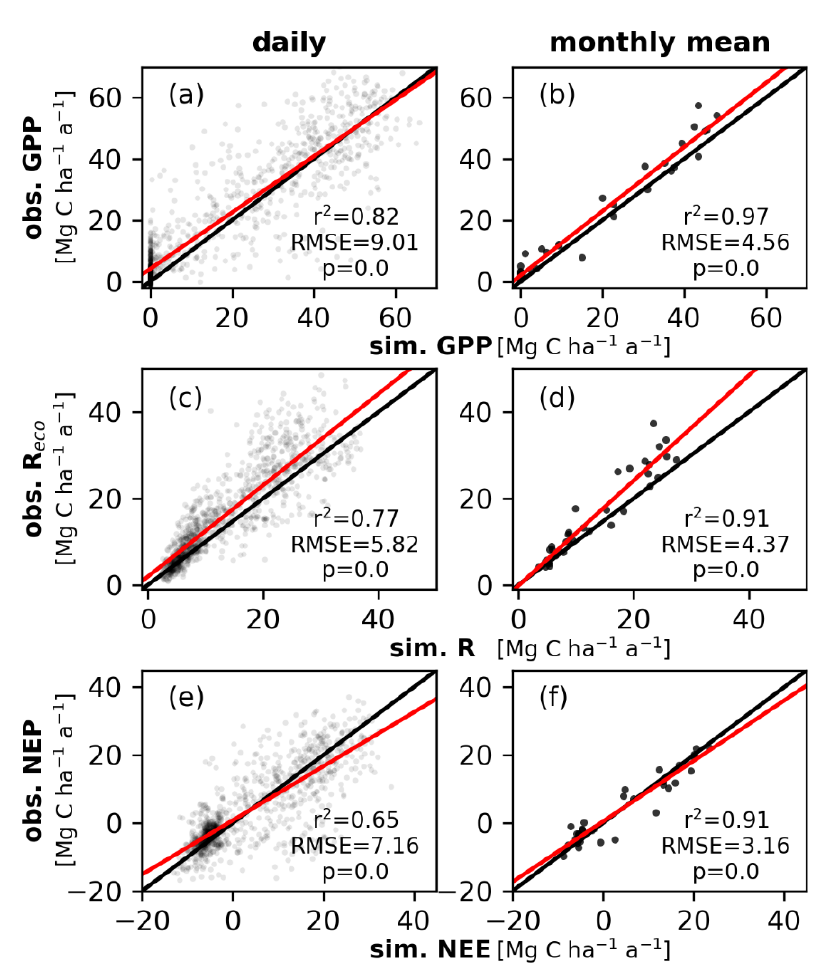
Figure A2. Daily (left, ( a ) GPP, ( c ) R eco , ( e ) NEP) and monthly (right, ( b ) GPP, ( d ) R eco , ( f ) NEP) mean simulated vs. observed ecosystem carbon fluxes ( NEP , GPP and R eco ) at Hohes Holz for the calibrated parameterization for three years (2015–2017).